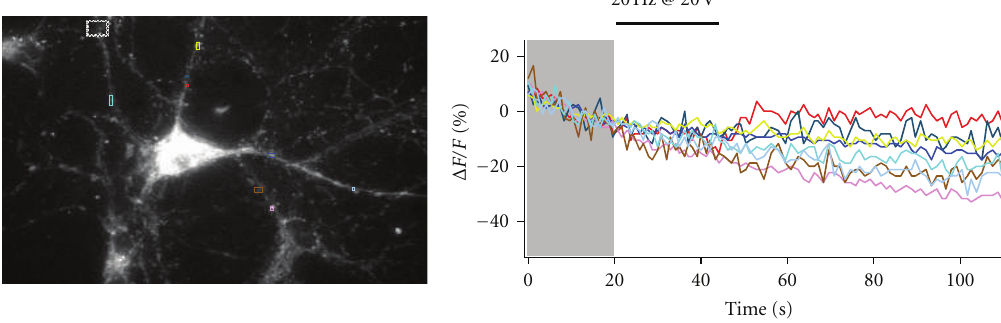
Figure 5: Neuron expressing BDNF-pHluorin and loaded with the Ca 2+ indicator fura-2 AM (image is of 488nm-excited BDNF-pHluorin). This cell was sensitive to pH (as in Figure 4) and responded to electrical stimulation with Ca 2+ transients (using 380 nm excitation, as in Figure 5). Consistent with activity-dependent BDNF release, dendritic BDNF-pHluorin puncta show decreases in intensity ( ∼ 20% deltaF/F) as a result of BDNF-pHluorin discharge from vesicles following full